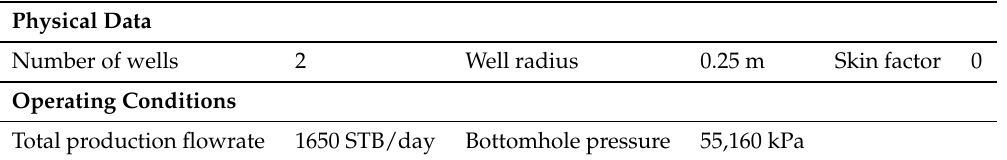
Table 2. Wells operational conditions.